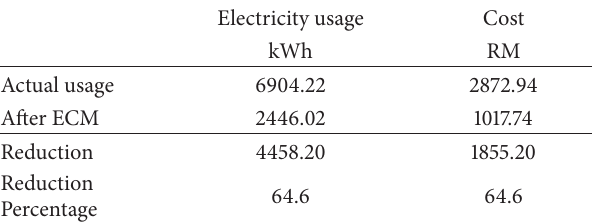
Table 9: Potential energy reduction and cost savings from the